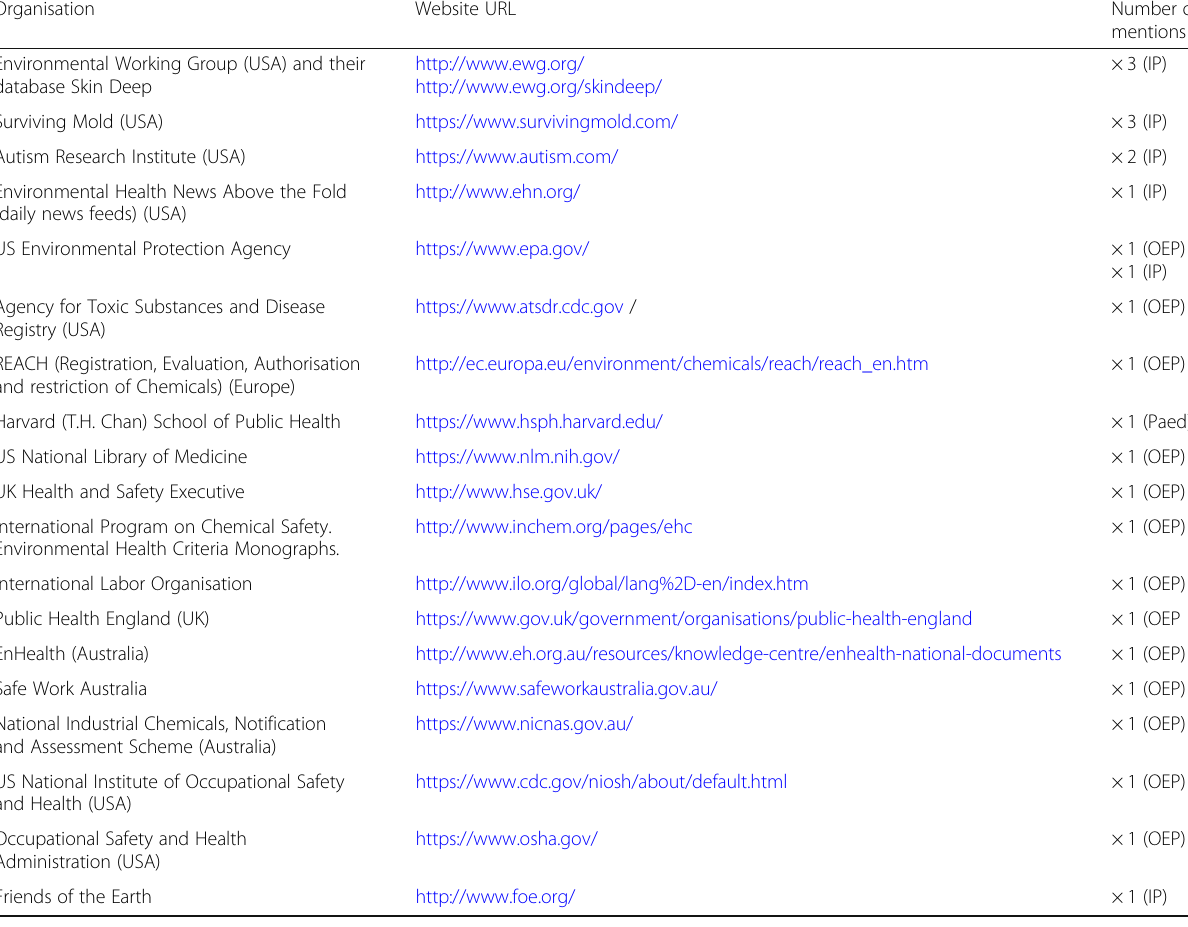
Table 6 Websites used as a resource by clinicians on